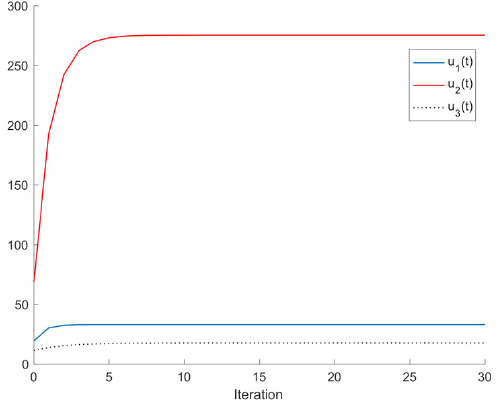
Figure 8. Feedback control signal in Example